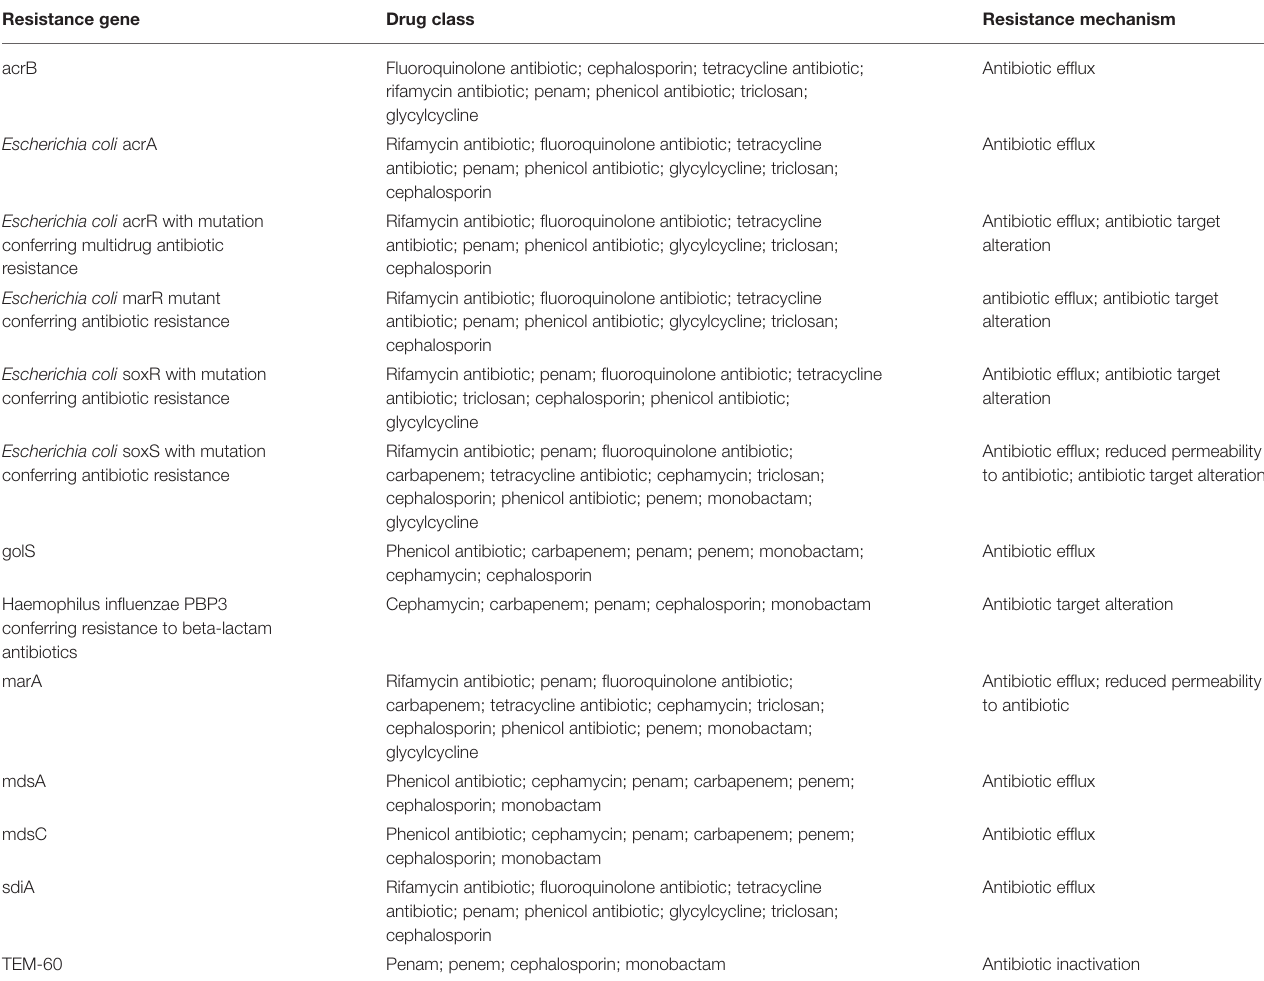
TABLE 1 | Cephalosporin-resistant genes shared by Salmonella spp. B3 and STC2. Resistance